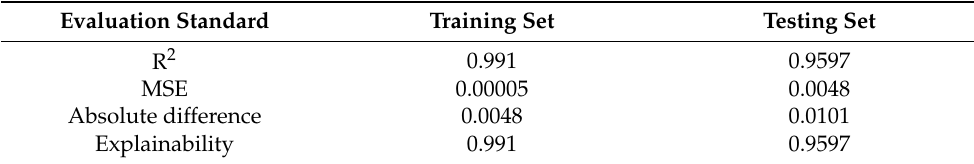
Table 5. Model training result